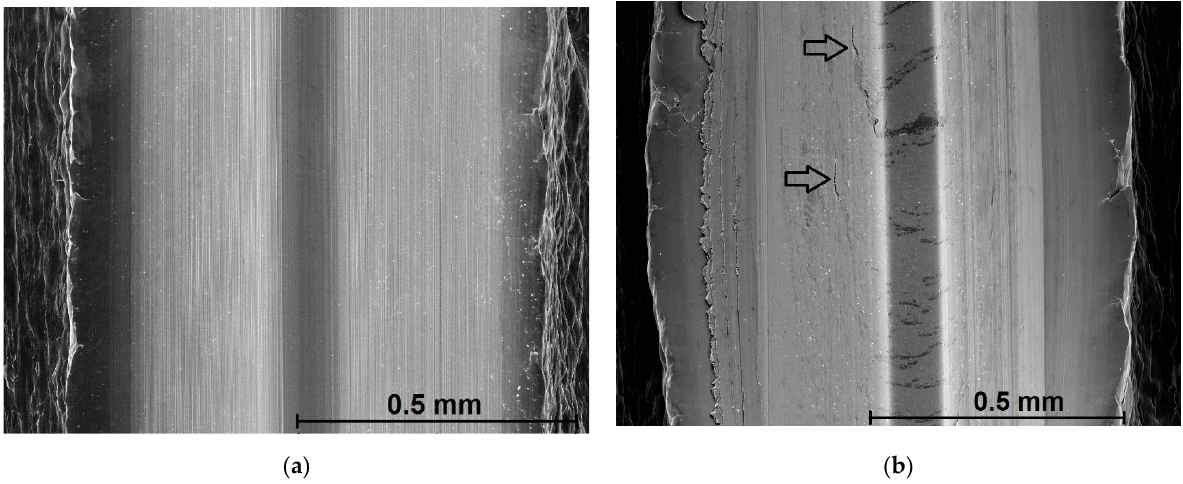
Figure 12. Surface quality of the threads: ( a ) smooth and glossy surface, a few point defects, (Ra 0.6–0.8 μ m). This quality was found solely for the lowest coefficients of friction (~0.1). ( b ) Line defects. This quality was found for the coefficients of friction in the range of 0.2–0.3 approximately.